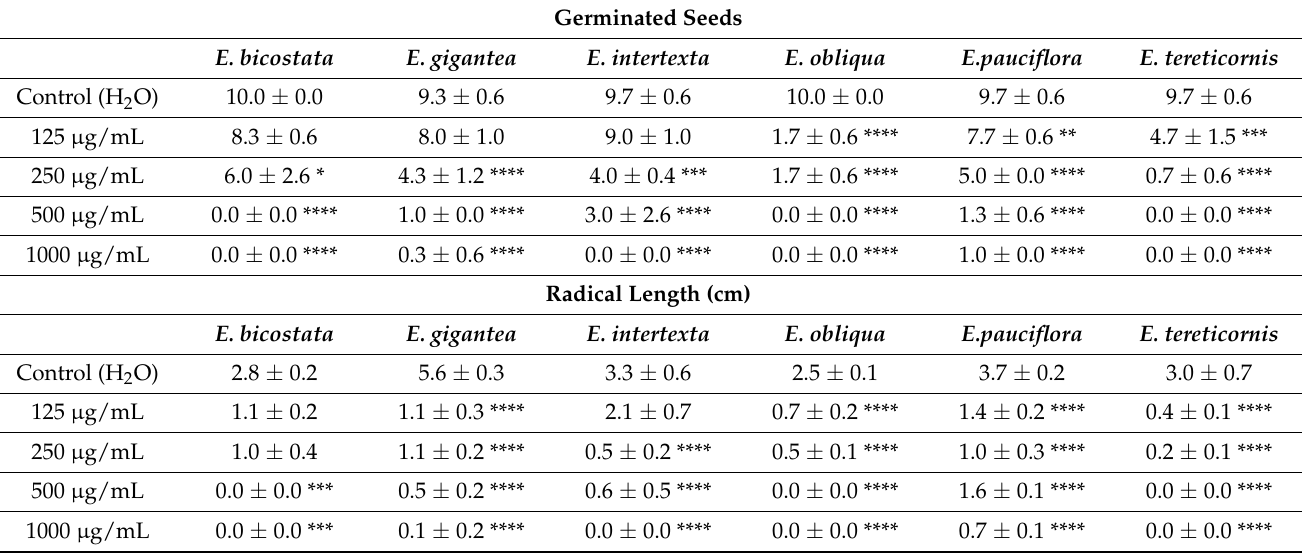
Table 3. Phytotoxic activity of the EOs on S. arvensis . Germinated Seeds